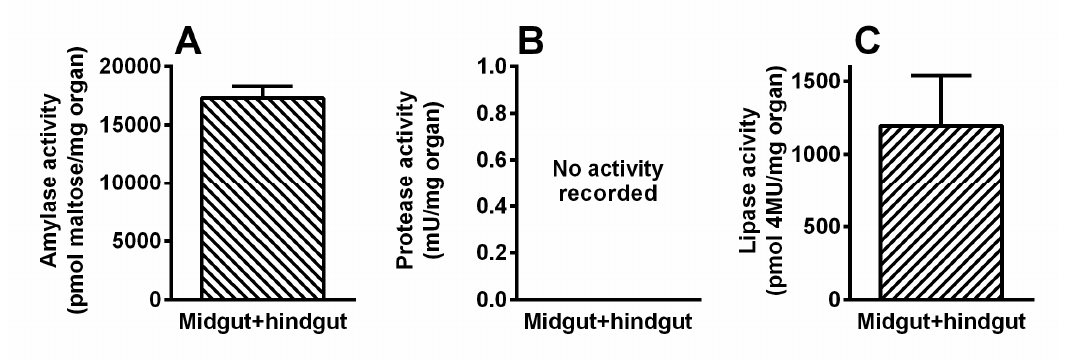
Figure 7. Levels of amylase ( A ), protease ( B ) and lipase ( C ) activities in T. giganteus gut. The bars represent mean ± SD of five (technical) replicates (n = 5).